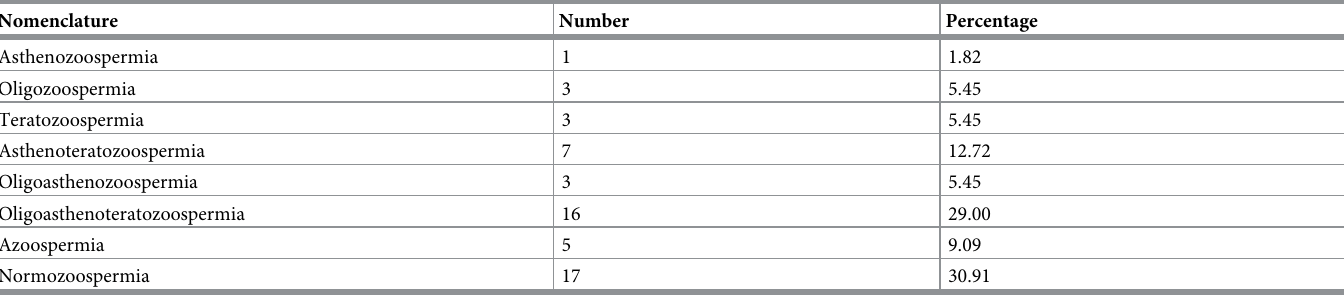
Table 2. Classification of characteristics of spermatozoa in the study participants using the WHO criteria for sperm concentration, motility and